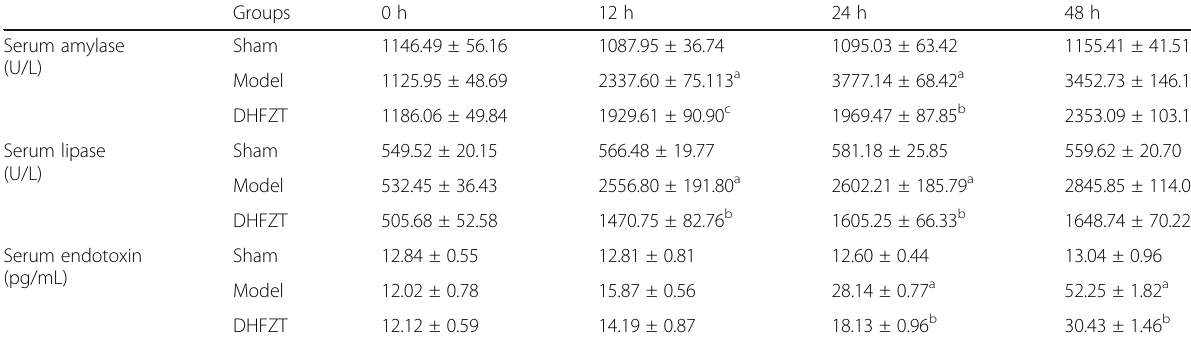
Table 5. DHFZT reduced the levels of serum amylase, lipase and endotoxin after SAP in rats